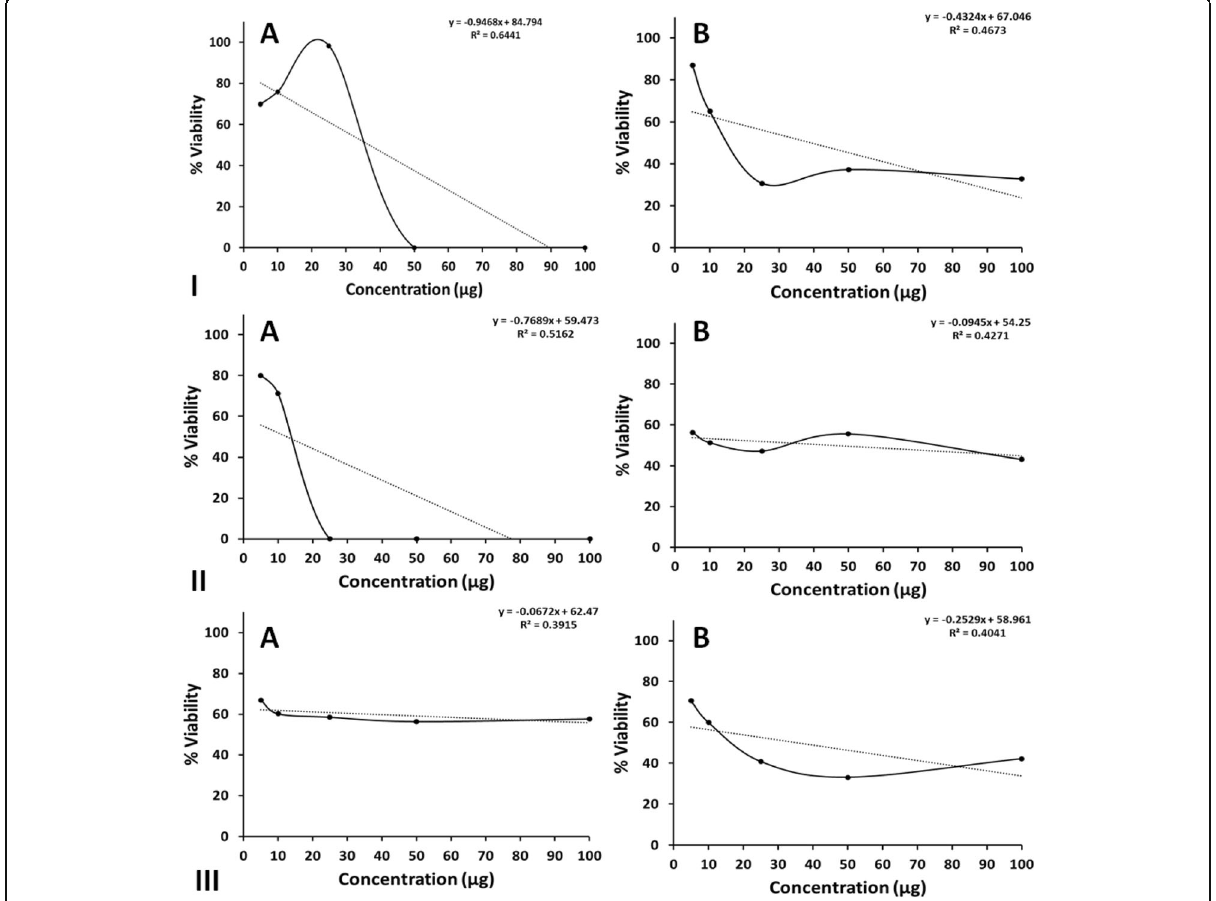
Fig. 4 Graph showing IC 50 of extracts of (I) M. pruriens , (II) A. longifolia and (III) S. indicus on (A) MCF7 and (B) A549 cell